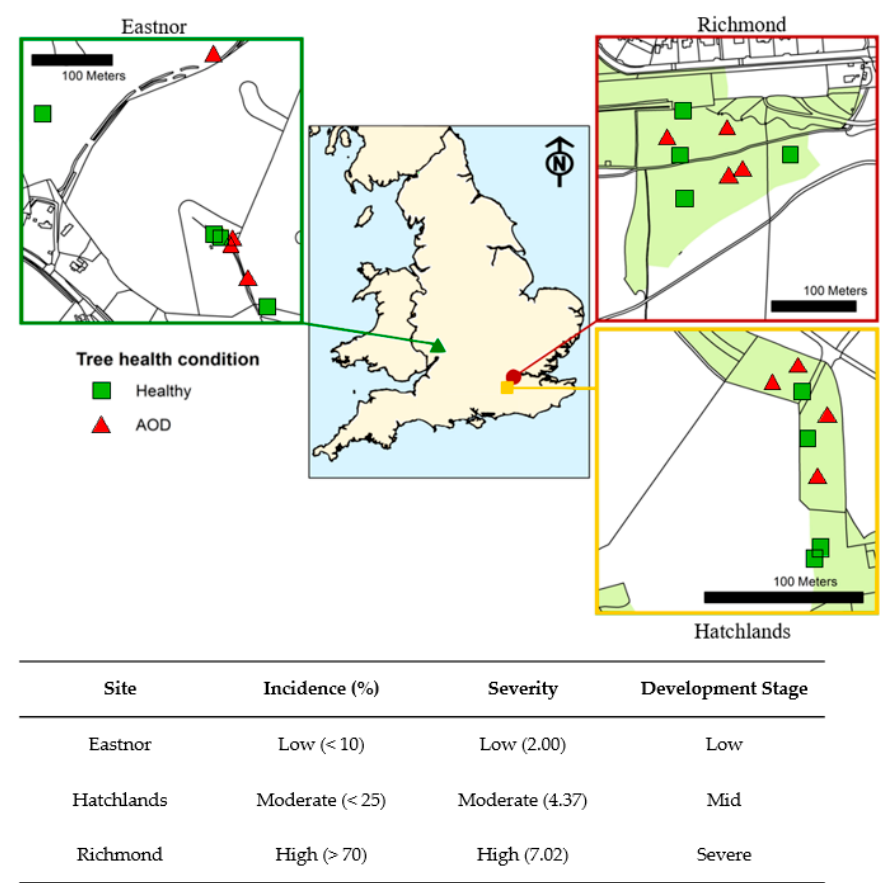
Figure 1. Location of the UK sites and sampled healthy (green square) and acute oak decline (AOD) (red triangle) trees in Eastnor (low-stage AOD, green), Hatchlands (mid-stage AOD, yellow), and Richmond (severe-stage AOD, red). Each point represents the specific GPS location of each sampled tree. The overview of the AOD developmental stage is presented in the table below the maps. AOD incidence and severity classifications were defined based on the monitoring data of the number of trees a ff ected (percentage) and bleeds per tree (average number of bleeds per stem), respectively. AOD developmental stage was set by combining disease incidence and